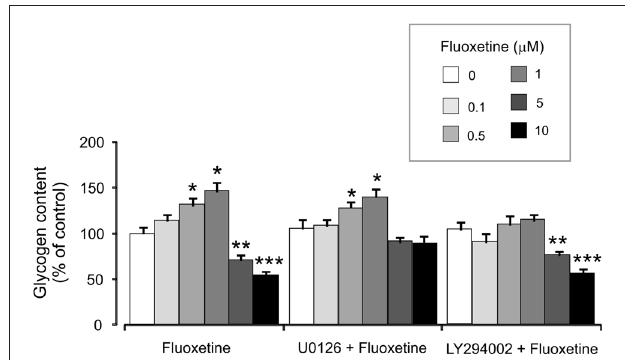
FIGURE 6 | Effect of fluoxetine on the glycogen content requires ERK or AKT activation in astrocytes. Cells were incubated for 2 weeks without any drug (0 µ M fluoxetine, control) or with 0.1, 0.5, 1, 5, or 10 µ M fluoxetine in the presence of U0126, an inhibitor of MEK or LY294002, an inhibitor of PI3K. After the experiment glycogen was determined by measuring glucose content fluorometrically before and after breakdown of remaining glycogen in astrocytes. Average glycogen contents are indicated as percentages of those under control conditions. SEM values are indicated by vertical bars. ∗ Indicates statistically significant ( P < 0.05) difference from 0 and 0.1 µ M groups but not from each other; ∗∗ indicates statistically significant ( P < 0.05) difference from 0, 0.1, 0.5 and 1 µ M groups; ∗∗∗ indicates statistically significant ( P < 0.05) difference from all other groups.